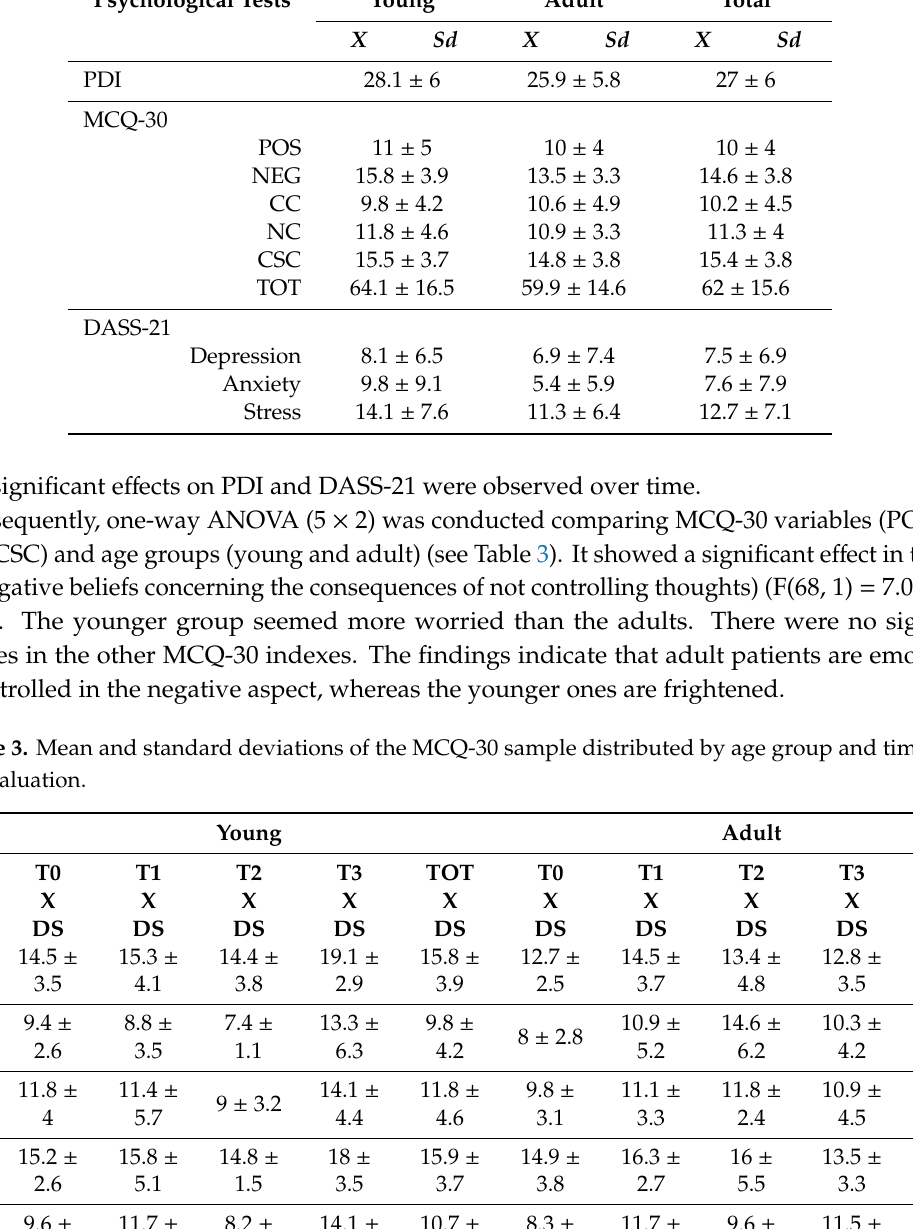
One-way ANOVA (3 × 2) comparing DASS-21 indexes (anxiety, depression, and stress) by age groups revealed a significant di ff erence in anxiety performance (F(68, 1) = 6.0; η = 0.6; p > 0.01): the younger group showed more anxiety than the